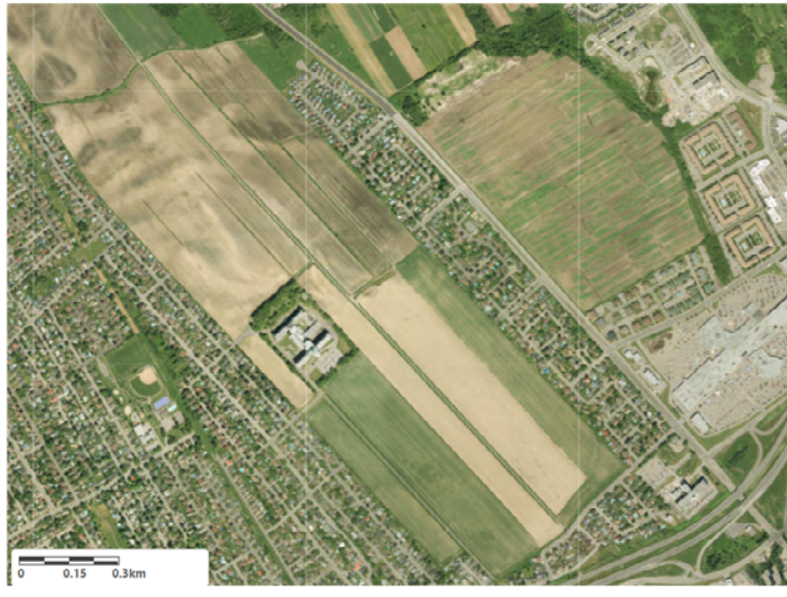
FIG. 1 Communauté métropolitaine de Québec (2013). Residential development (1:72 224).